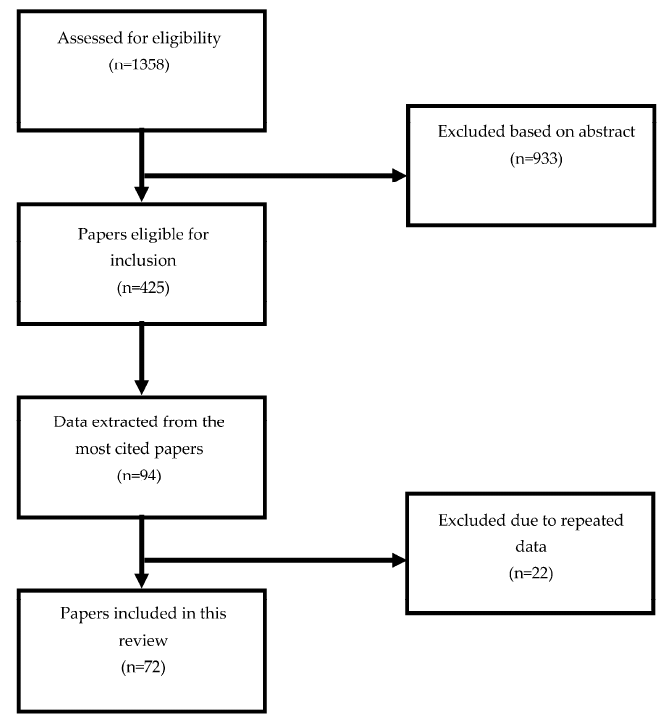
Figure 1. CONSORT diagram.